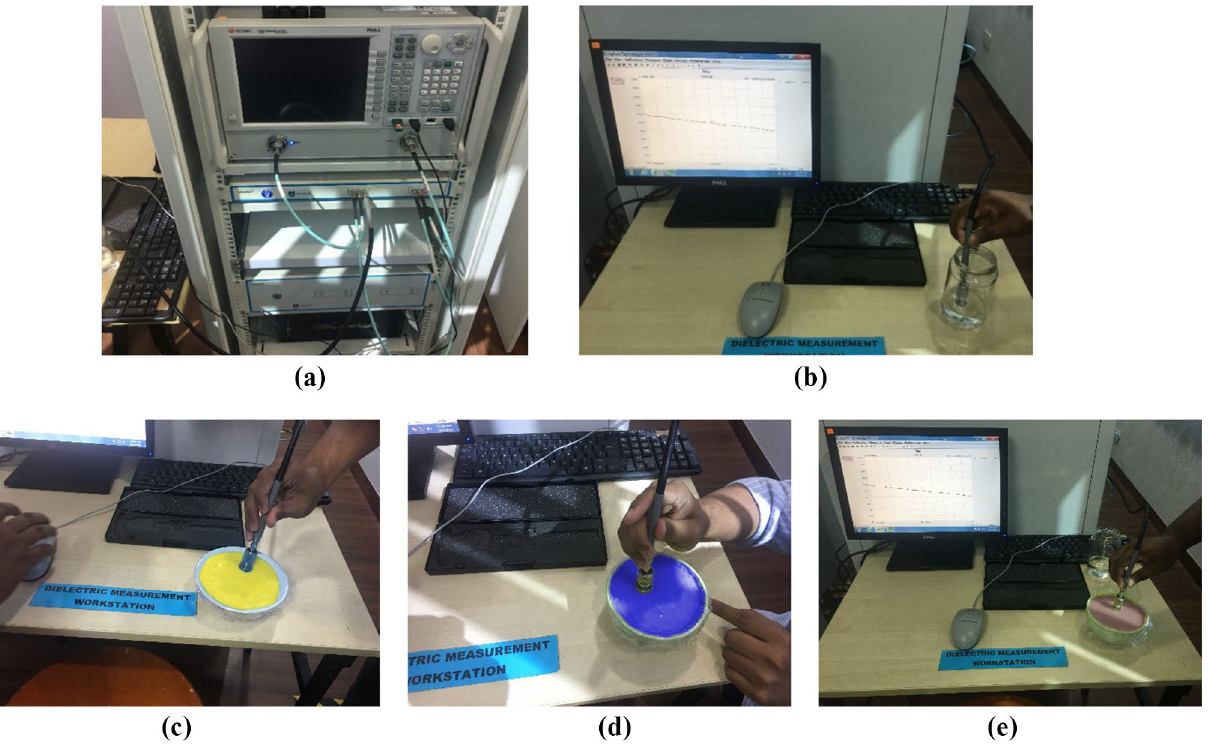
Figure 22. Phantom measurement process: ( a ) Phantom measurement setup with PNA; ( b ) Calibration with sterile water by open-ended coaxial probe; ( c – e ) Fabricated phantom measurement process using probe kit: DURA, CSF, and Gray Matter samples respectively.